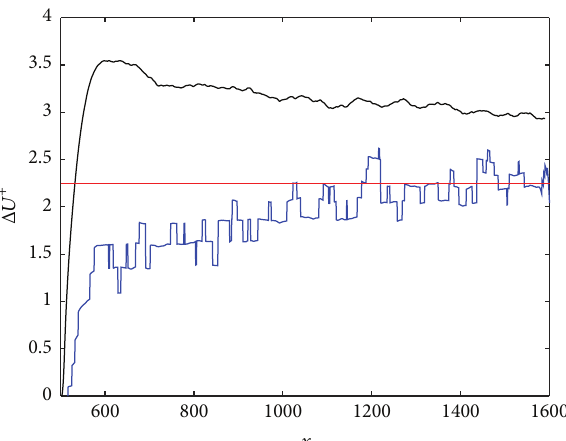
Figure 5: The variation of the velocity shift Δ𝑈 + in the downstream direction ( 𝑥 ). (Black) Δ𝑈 + from (19). (Blue) Δ𝑈 + taken from the velocity profiles at the position where the local minimum of (28) is found. (Red) Δ𝑈 + from expression